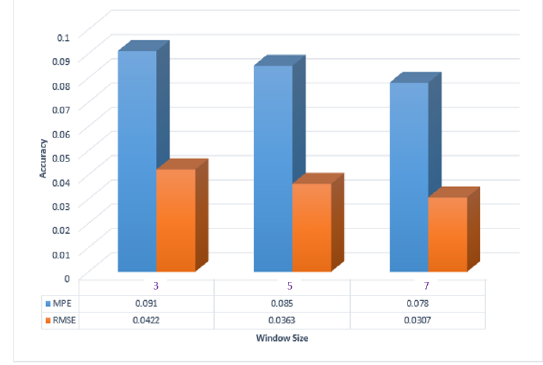
Figure 2 The effect of different window sizes using the moving median smoothing technique.